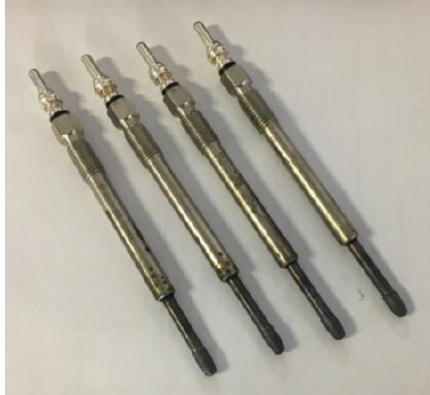
Figure 6. Prototype glow plugs with the elongated heating part (34 mm).